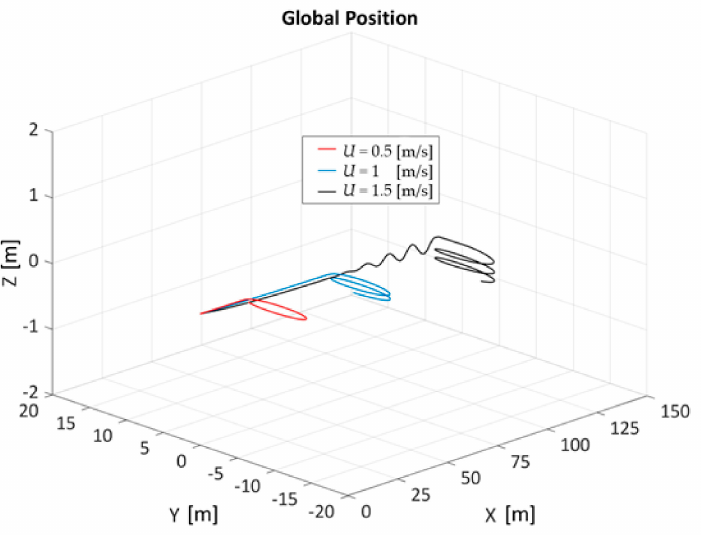
Figure 12. The SFRM’s trajectories at different sailing speeds in the turning circle